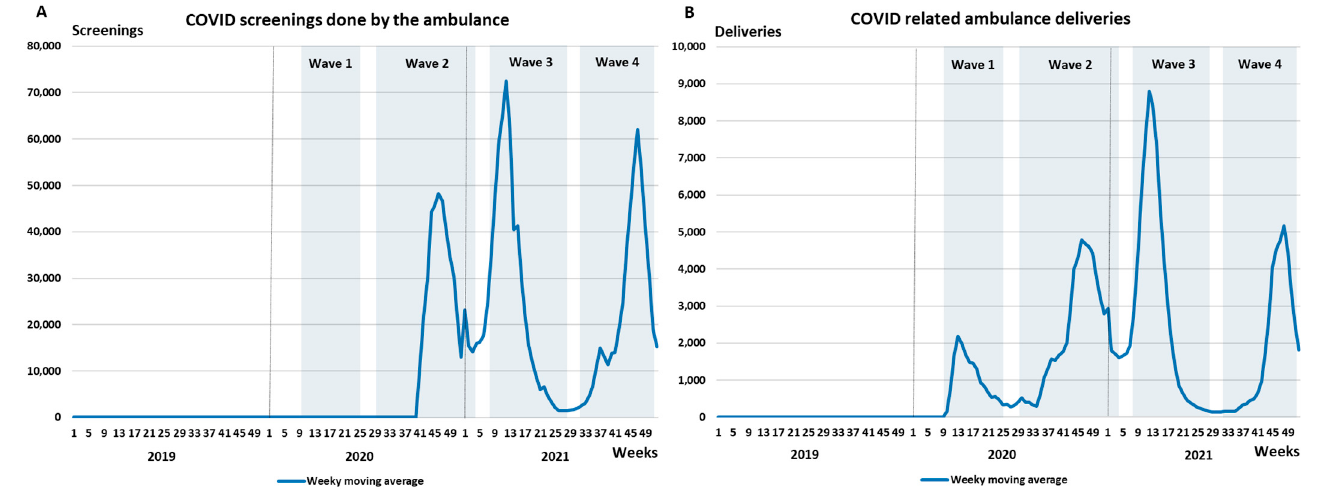
Figure 2. Weekly moving average of ( A ) COVID-19 screenings and ( B ) COVID-19-related deliveries by the NAS between 2019 and 2021.